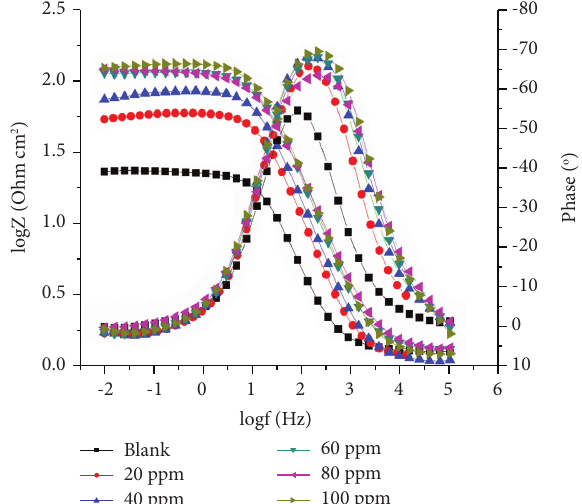
Figure 4: Bode magnitude plot and phase angle plot for the corrosion of mild steel in 1M HCl in the absence and presence of various concentrations of AMP.